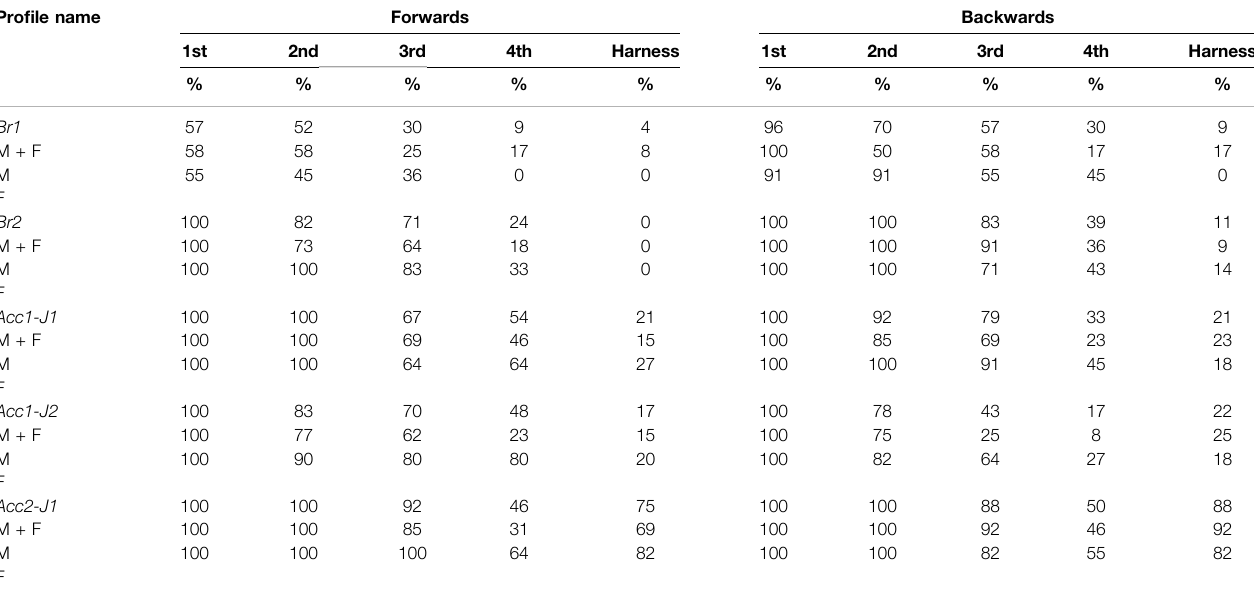
TABLE 3 | Percentage of sequential steps (1st – 4th) during balance recovery and the percentage of harness deployments for the forward- and backward-facing volunteers